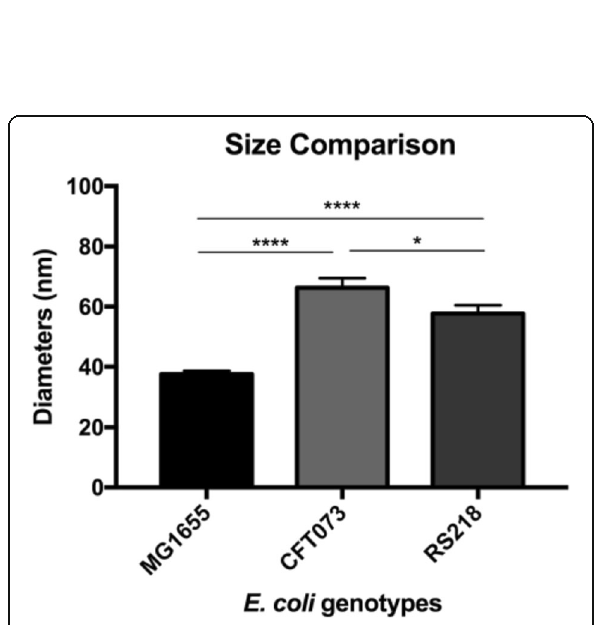
Fig. 4 Molecular sizes of E. coli genotypes. The diameters of surface proteins were detected by AFM and processed via one-way ANOVA for the multiple comparisons. **** p < 0.001 and * p <